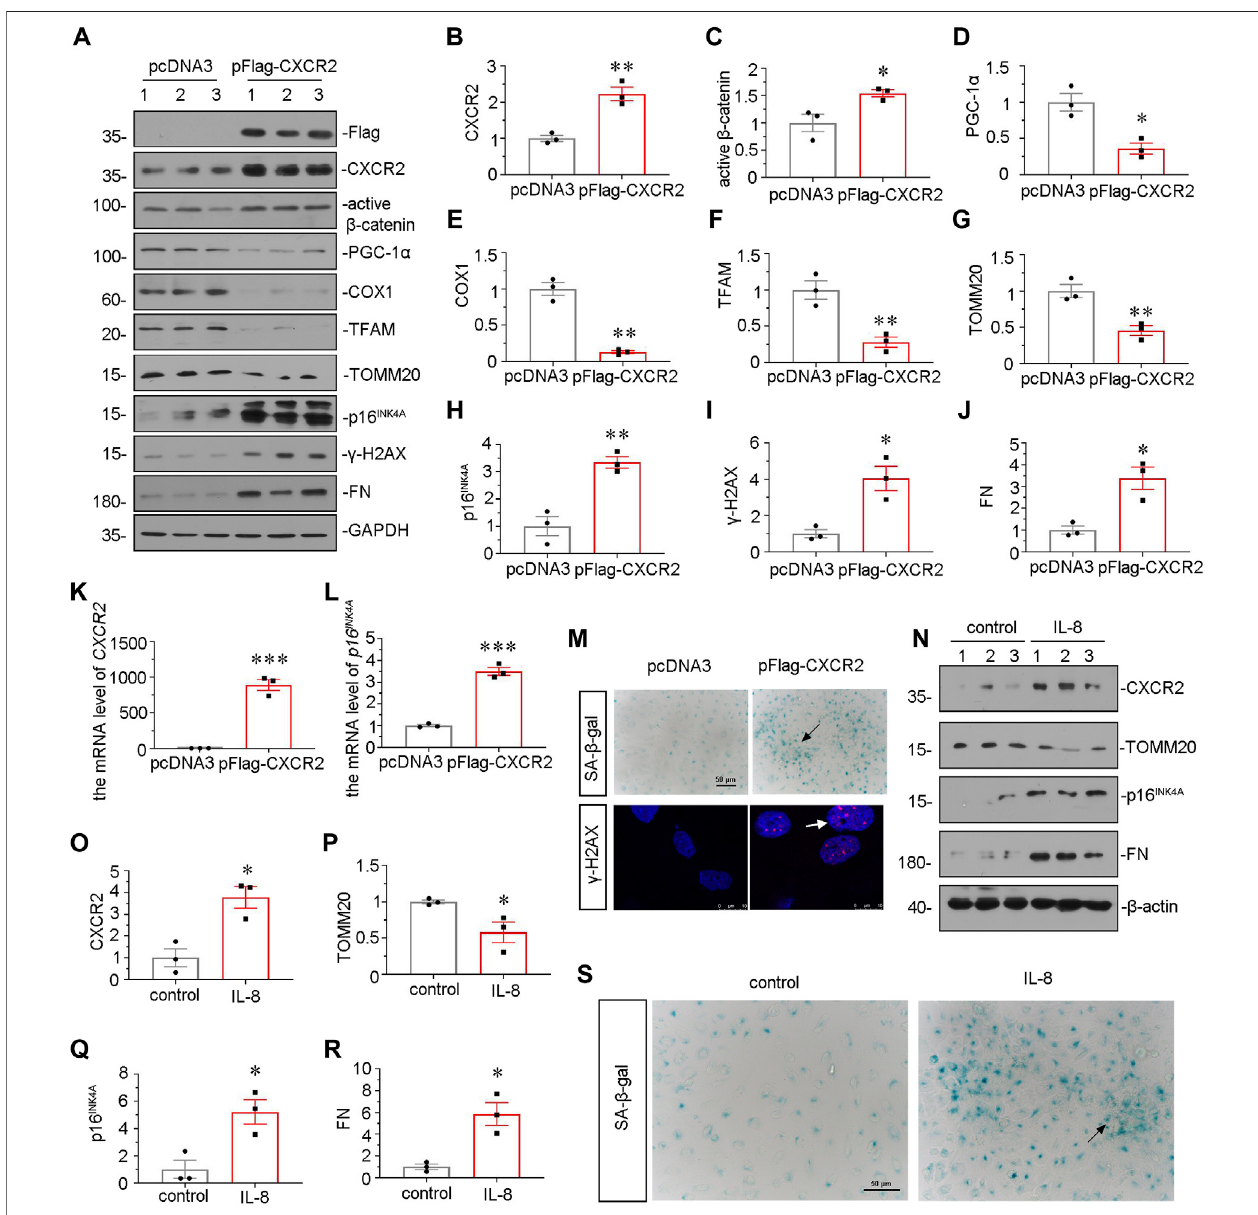
FIGURE 7 | CXCR2 promotes mitochondrial dysfunction and tubular senescence in vitro . (A – J) Representative micrographs of western blot and quantitative statistical data show renal expression of (B) CXCR2 (C) active β -catenin, (D) PGC-1 α , (E) COX1, (F) TFAM, (G) TOMM20, (H) p16 INK4A , (I) γ -H2AX and (J) FN in each group.* p < 0.05,** p < 0.01,*** p < 0.001,versusthepcDNA3group( n =3). (K,L) GraphicalrepresentationsshowtherelativemRNAlevelof (K) CXCR2 and (L) p16 INK4A in different groups. *** p < 0.001 versus the pcDNA3 group ( n = 3). (M) Representative micrographs show SA- β -gal staining and γ -H2AX expression in different groups. Frozen sections were performed by SA- β -gal and γ -H2AX immuno fl uorescence staining. Arrows indicates positive staining. Scale bar = 50 or 10 μ m. (N – R) Representativemicrographsofwesternblotandquantitativestatisticaldatashowproteinlevelsof (O) CXCR2, (P) TOMM20, (Q) p16 INK4A and (R) FNineachgroup.* p < 0.05versusthecontrolgroup( n =3). (S) RepresentativemicrographsshowSA- β -galstainingineachgroup.FrozenrenalsectionswereperformedbySA- β -galstaining. Arrows indicate positive staining. Scale bar, 50 μ m.